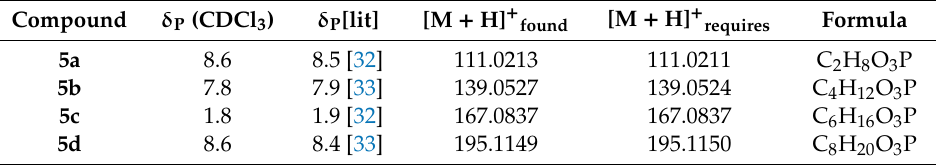
Table 9. 31 P NMR and HRMS data for the known compounds 5a – d